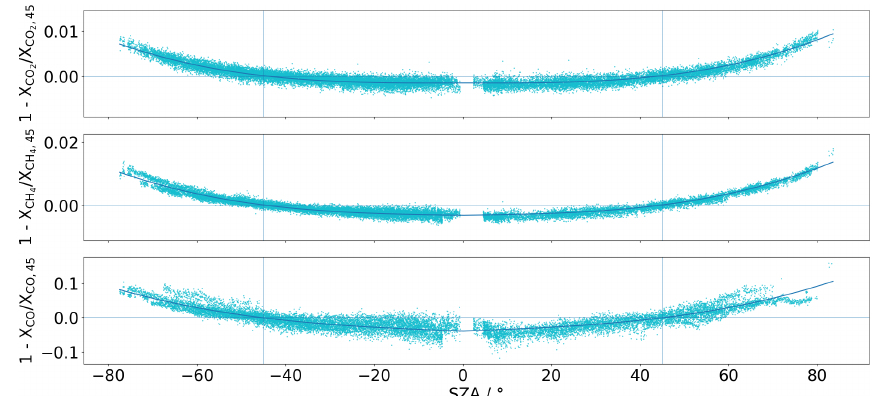
Figure 3. SZA dependency of the retrieved XCO 2 (upper panel), XCH 4 (middle panel), and XCO (lower panel) and the inferred correction polynomial (solid line). Negative SZAs denote morning and positive SZAs afternoon measurements.